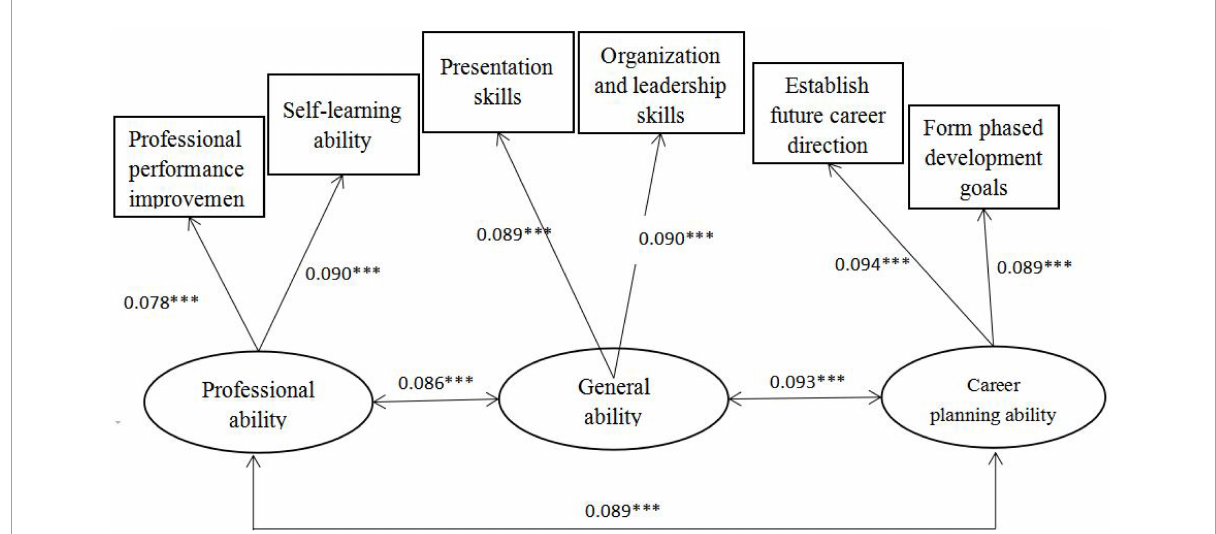
FIGURE1 Construct validity analysis chart of academic achievement (after normalization). Significance level * P < 0.1, ** P < 0.05, and *** P < 0.01.